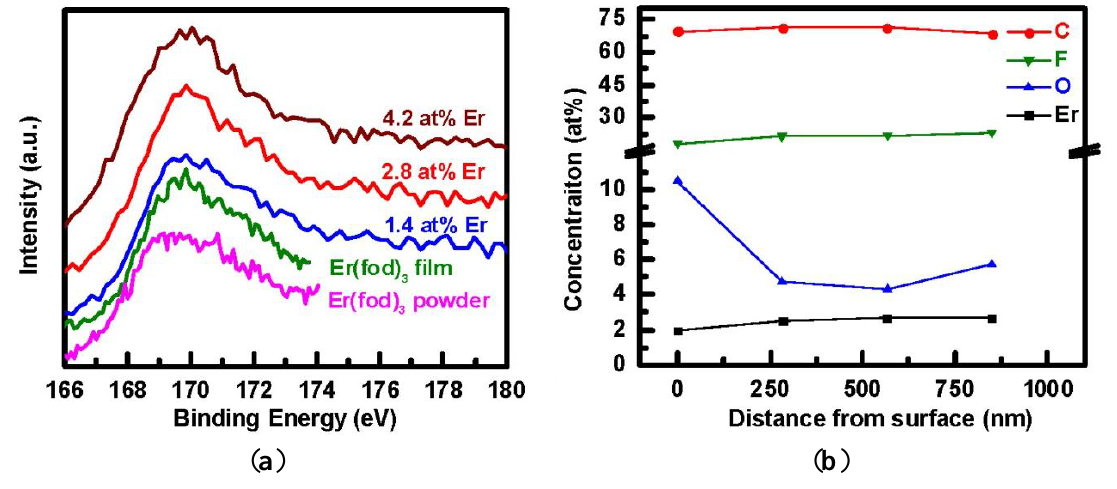
Figure 4. ( a ) XPS spectra of the three a-C:D(Er) films, Er(fod) film (evaporated in the 3 vacuum chamber with CD precursor gas flowing without plasma ignition), and the 4 as-received stoichiometric Er(fod) powder. The curves have been shifted vertically for 3 clarity of presentation; ( b ) Depth profile of C, F, O, and Er concentrations in a-C:D(Er) film deposited at 60 W of RF power and 80 °C as determined from XPS